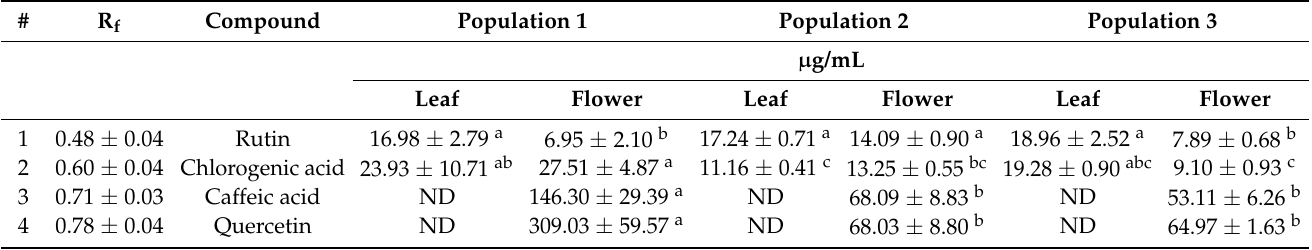
Table 3. Phenolic compounds identified by High-Performance Thin-Layer Chromatography (HPTLC) in methanolic extracts from leaves and flowers of Cosmos sulphureus